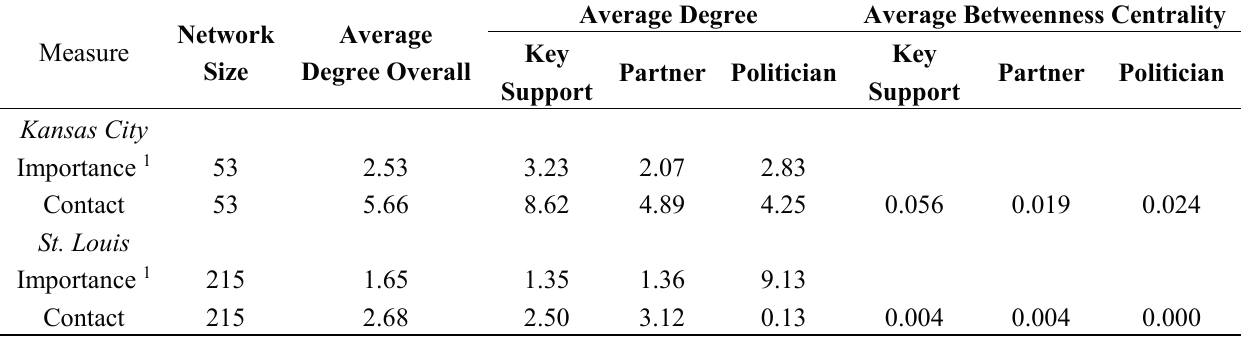
Table 2. Size, average degree, and average betweenness centrality measures for entire networks, key support, partner, and politician members.